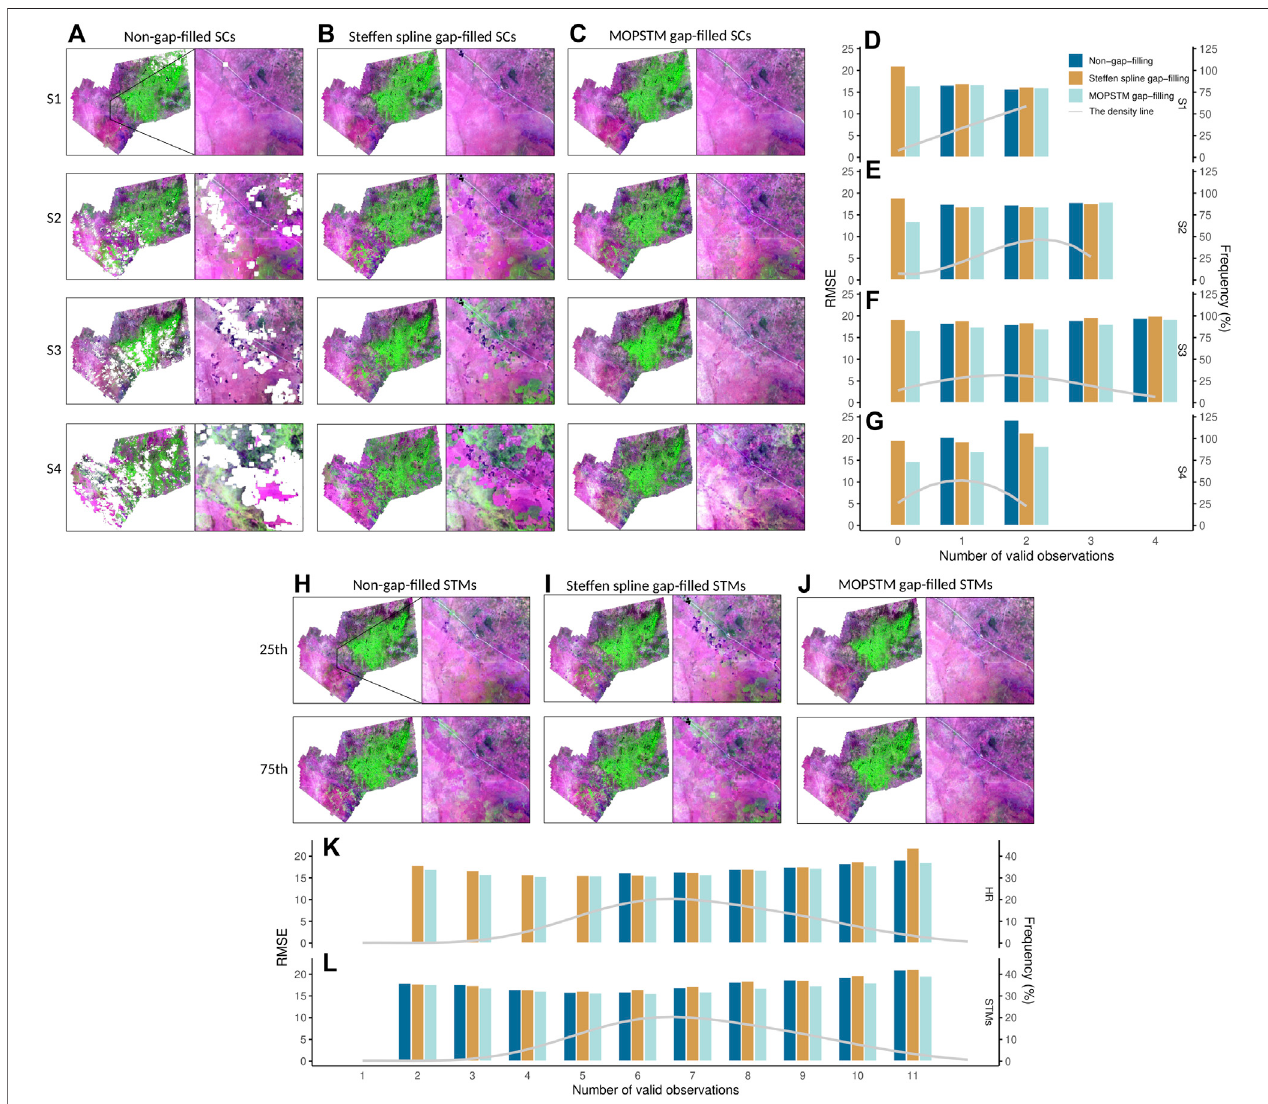
FIGURE5| DependenceofRMSEonthenumberofobservationsforfourSCs,STMsandHRcoef fi cientsderivedfromLandsatimagesthatwerenotgap- fi lledand images that were gap- fi lled. (A) SCs without gap- fi lling; (B) SCs with Steffen spline gap- fi lling; (C) SCs with MOPSTM gap- fi lling; (D) SC1 RMSE; (E) SC2 RMSE; (F) SC3 RMSE; (G) SC4 RMSE; (H) STMs (25th and 75th percentile metrics) without gap- fi lling; (I) STMs (25th and 75th percentile metrics) with Steffen spline gap- fi lling (J) STMs (25th and 75th percentile metrics) with MOPSTM gap- fi lling (K) HR RMSE; and (L) STMs RMSE. The x -axis for (D – G) , (K,L) is the number of the valid observations of each pixel through the time series, y -axis on the left is the RMSE, y -axis on the right is the frequency (in percentage) of number of valid observations, displayed in grey lines.